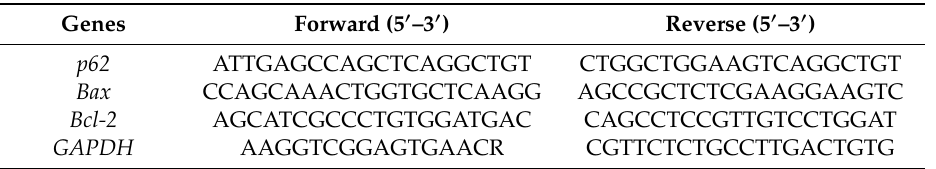
Table 1. Primer sequences for